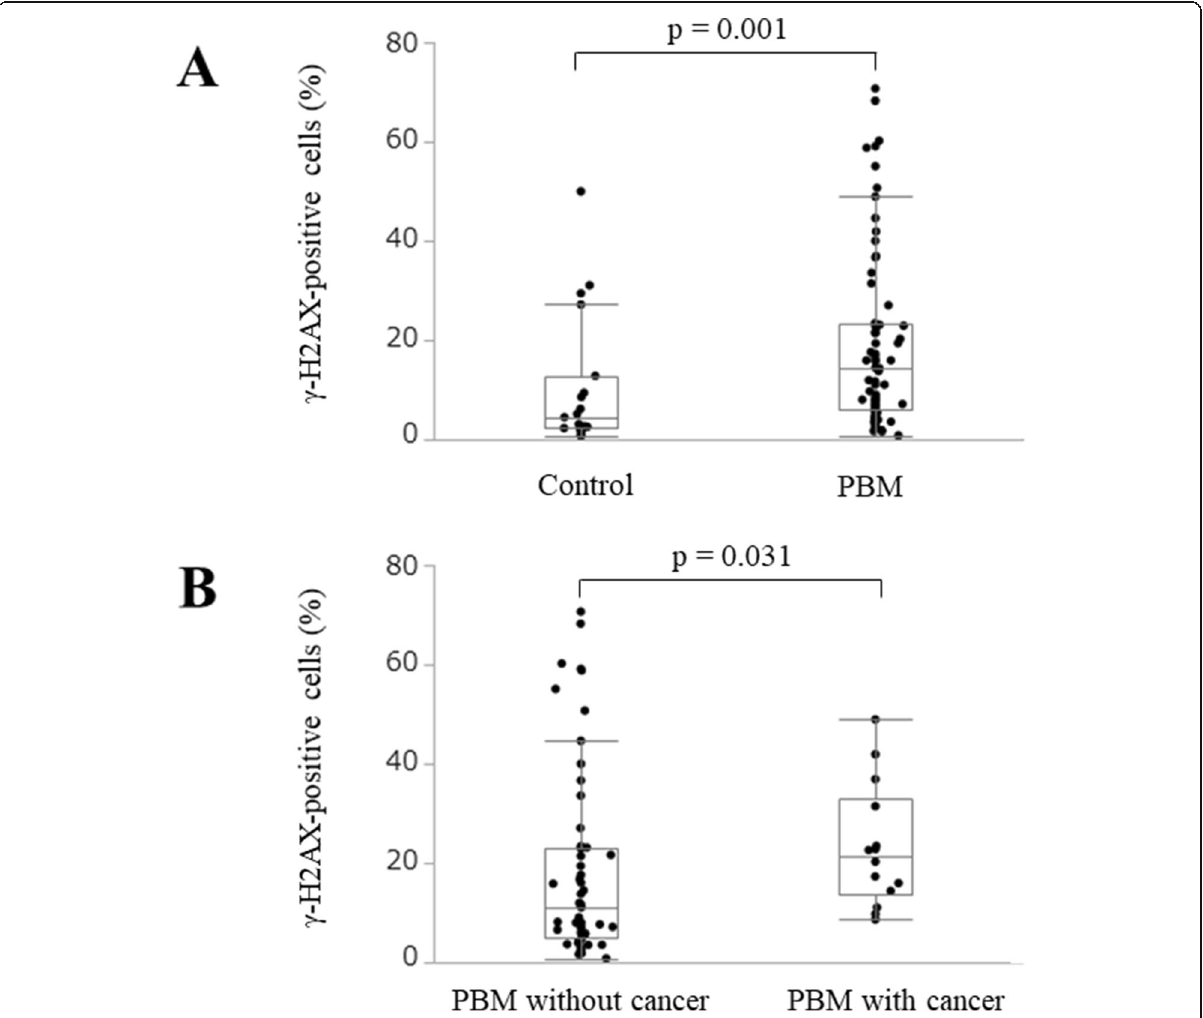
Fig. 3 Comparisons of the positive proportion of γ -H2AX expression. A The expression of γ -H2AX was significantly higher in cases with PBM than in the control group ( p = 0.001). B The expression of γ -H2AX was significantly higher in PBM cases with carcinoma than in those without ( p = 0.031). γ -H2AX, phosphorylated H2AX at Ser139; PBM, pancreaticobiliary